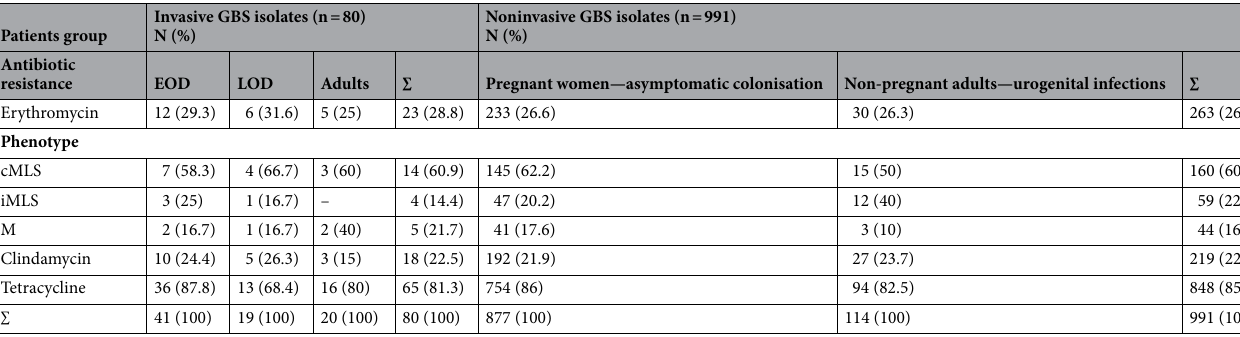
Table 3. Distribution of erythromycin, clindamycin and tetracycline resistance rates and macrolide resistance phenotypes in 1071 invasive and non-invasive isolates of Group B streptococci within different patient groups.